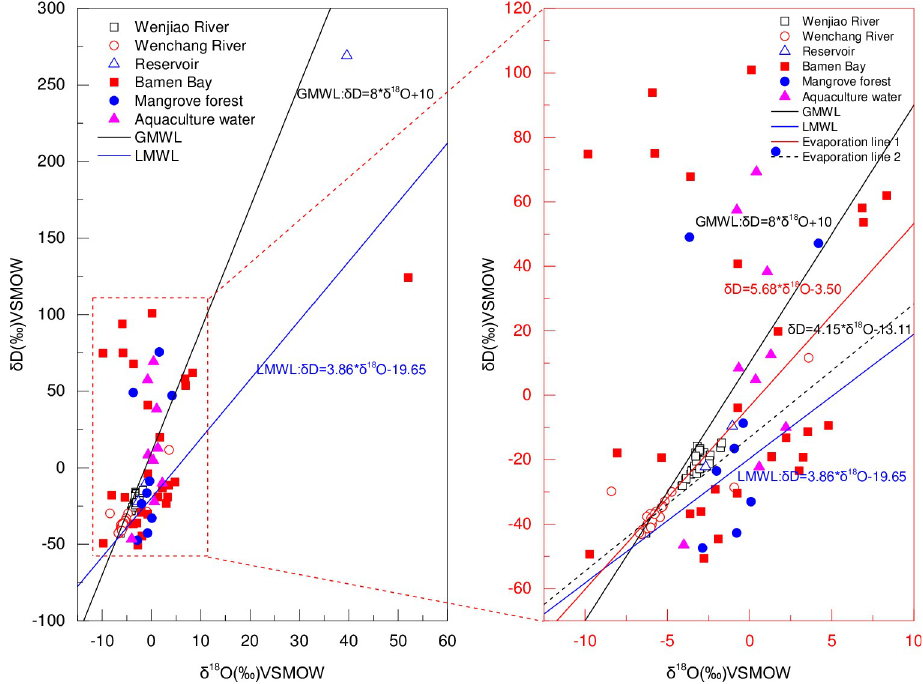
Fig 10. δ D– δ 18 O relationships from surface water samples with regression line in Bamen Bay basin. The global and local meteoric water line is also given for